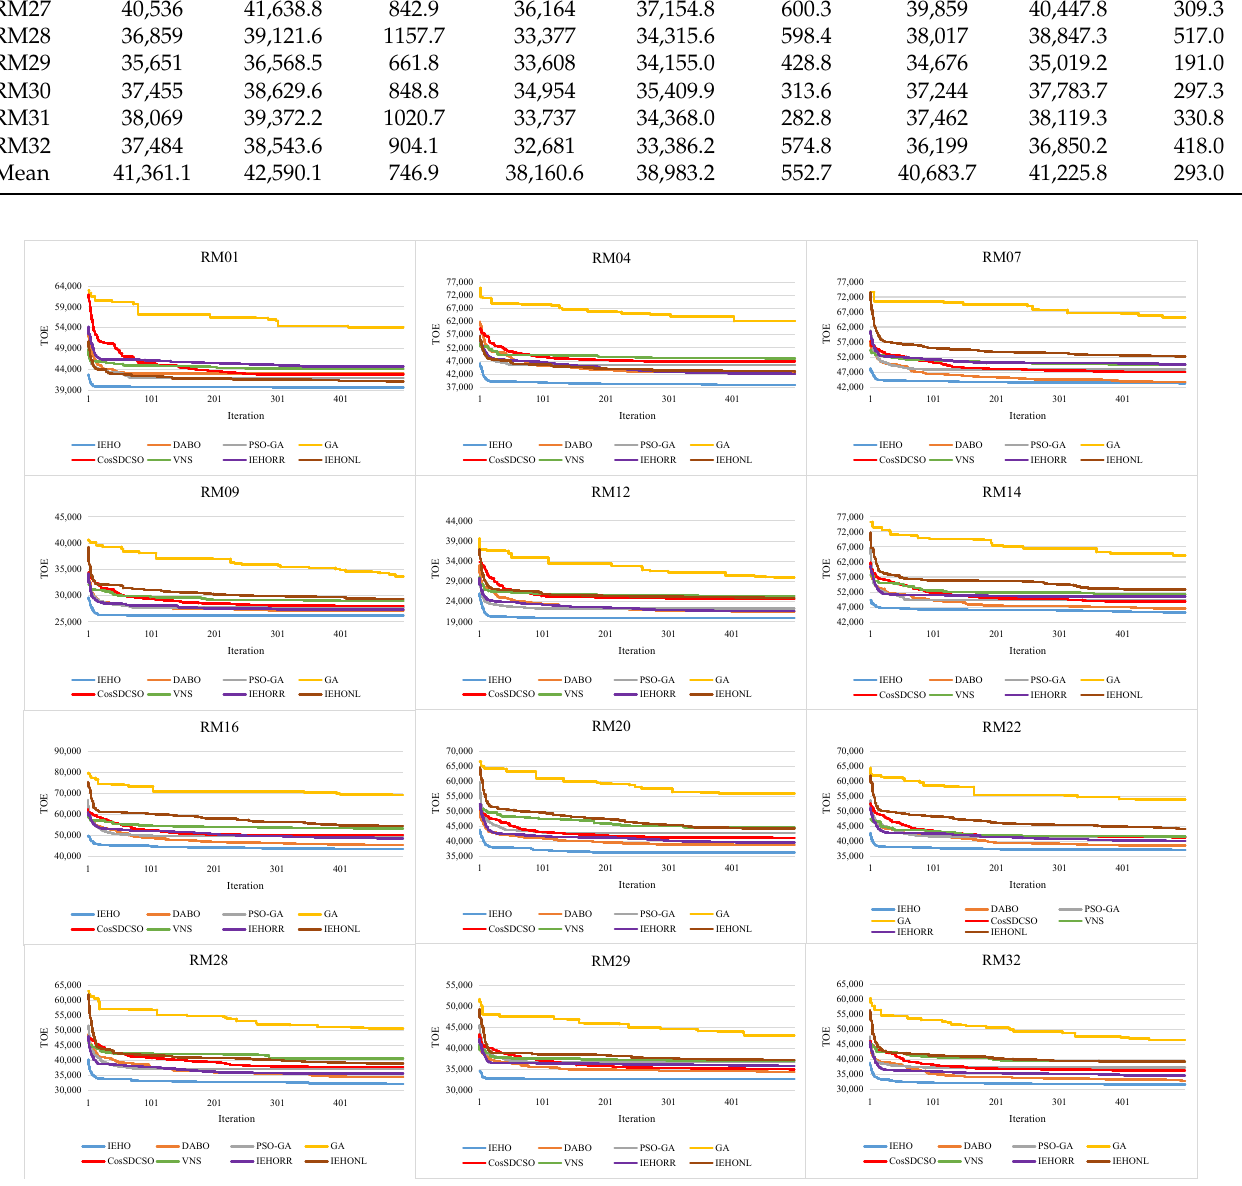
Figure 8. Convergence curves of different algorithms.